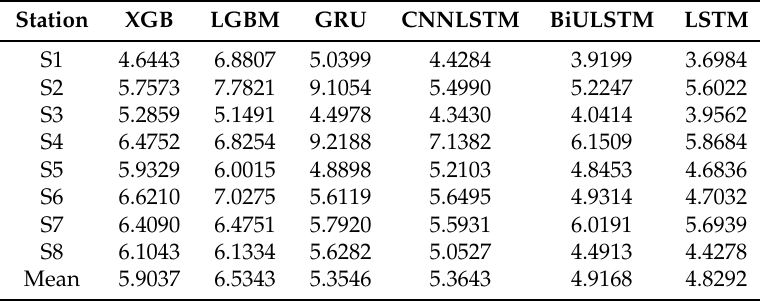
Table 6. Models results for RMSE (µg/m 3 ).